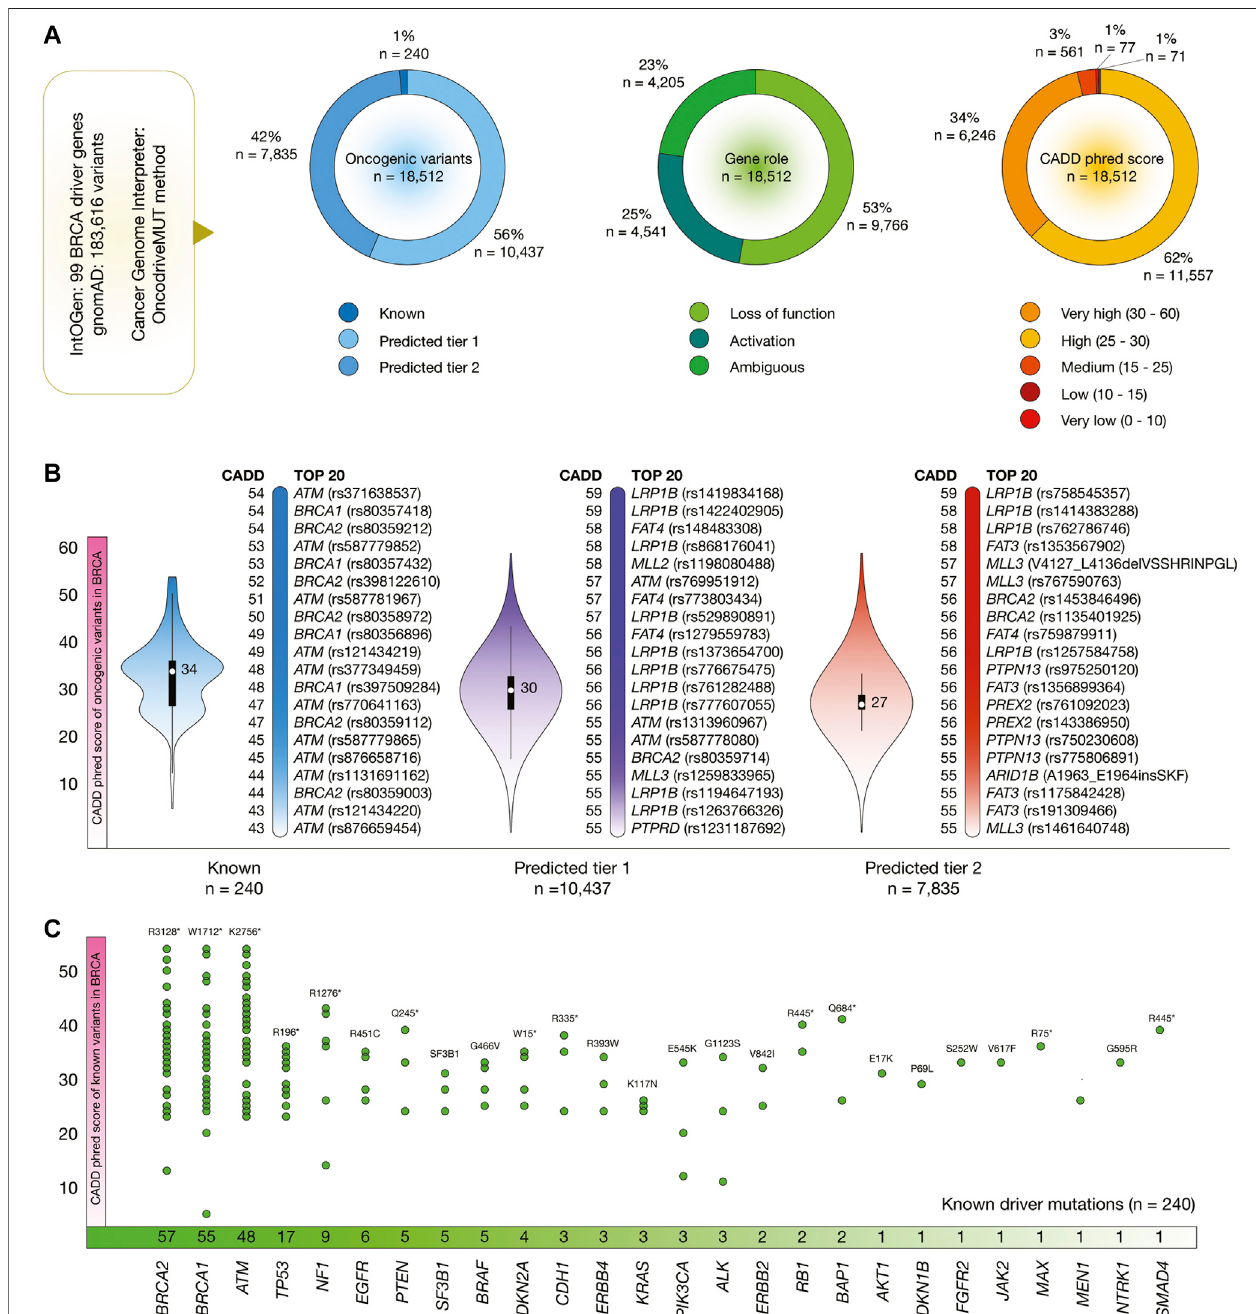
FIGURE 3 | BRCA driver genes, oncogenic variants, and deleteriousness scores. (A) Features of BRCA driver genes and oncogenic variants. (B) Bean plots of CADDphredscoresofBRCAoncogenicvariants,andrankingofknownoncogenicvariantswiththehighestCADDphredscores. (C) BRCAdrivergeneswiththehighest number of oncogenic